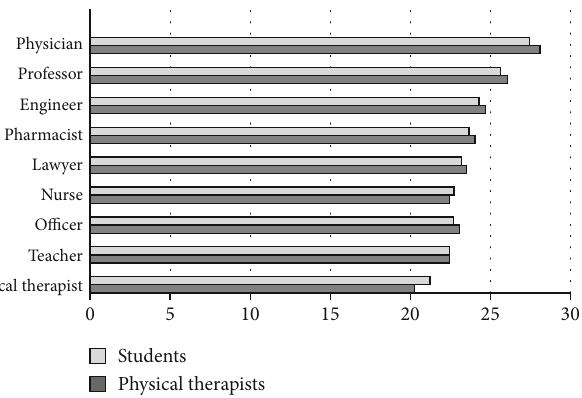
Figure 6: Mean ranks for overall occupational